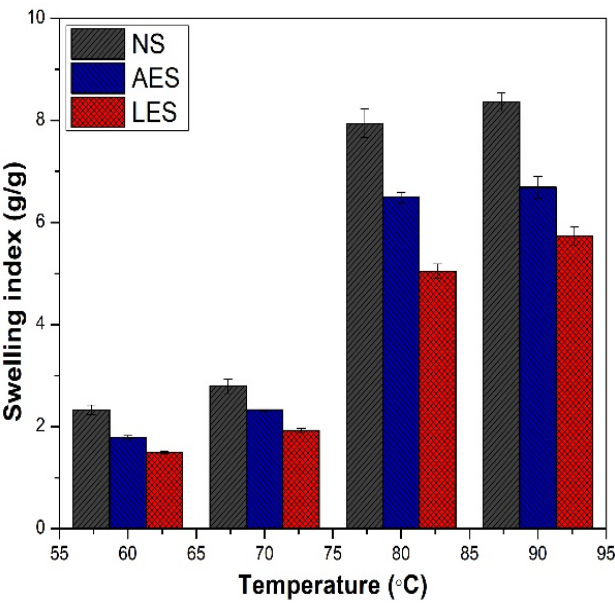
Figure 2. Swelling index of native and organic acid-treated talipot starches.